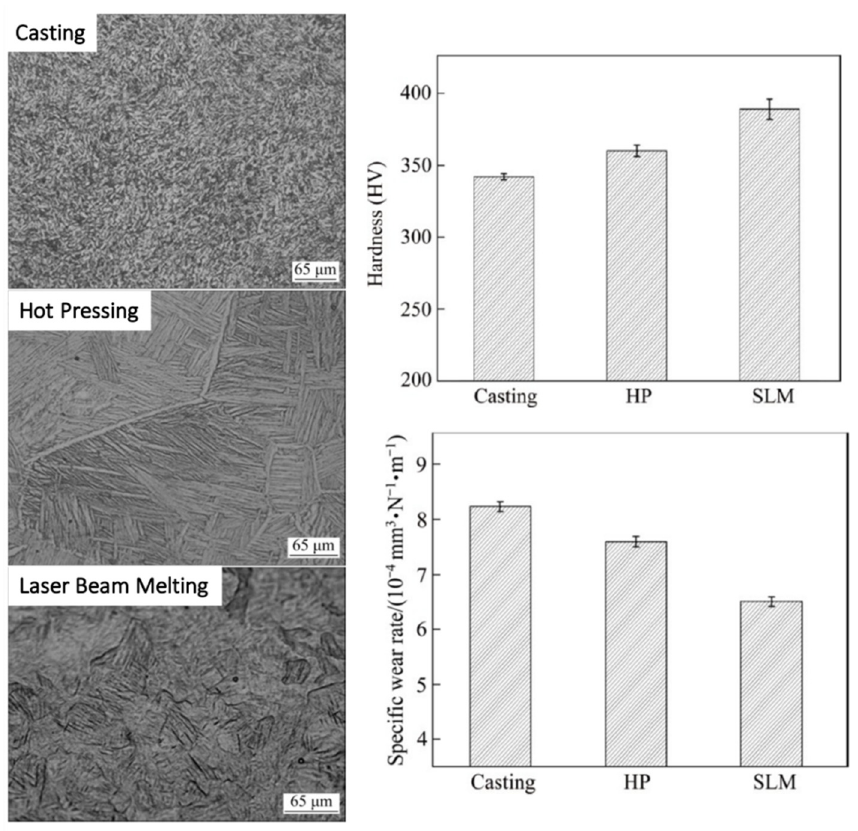
Figure 12. Optical micrographs, phase content (%), hardness and wear rate of Ti6Al4V fabricated by different processing routes (adapted with permission from [2]. Copyright 2017 Elsevier).